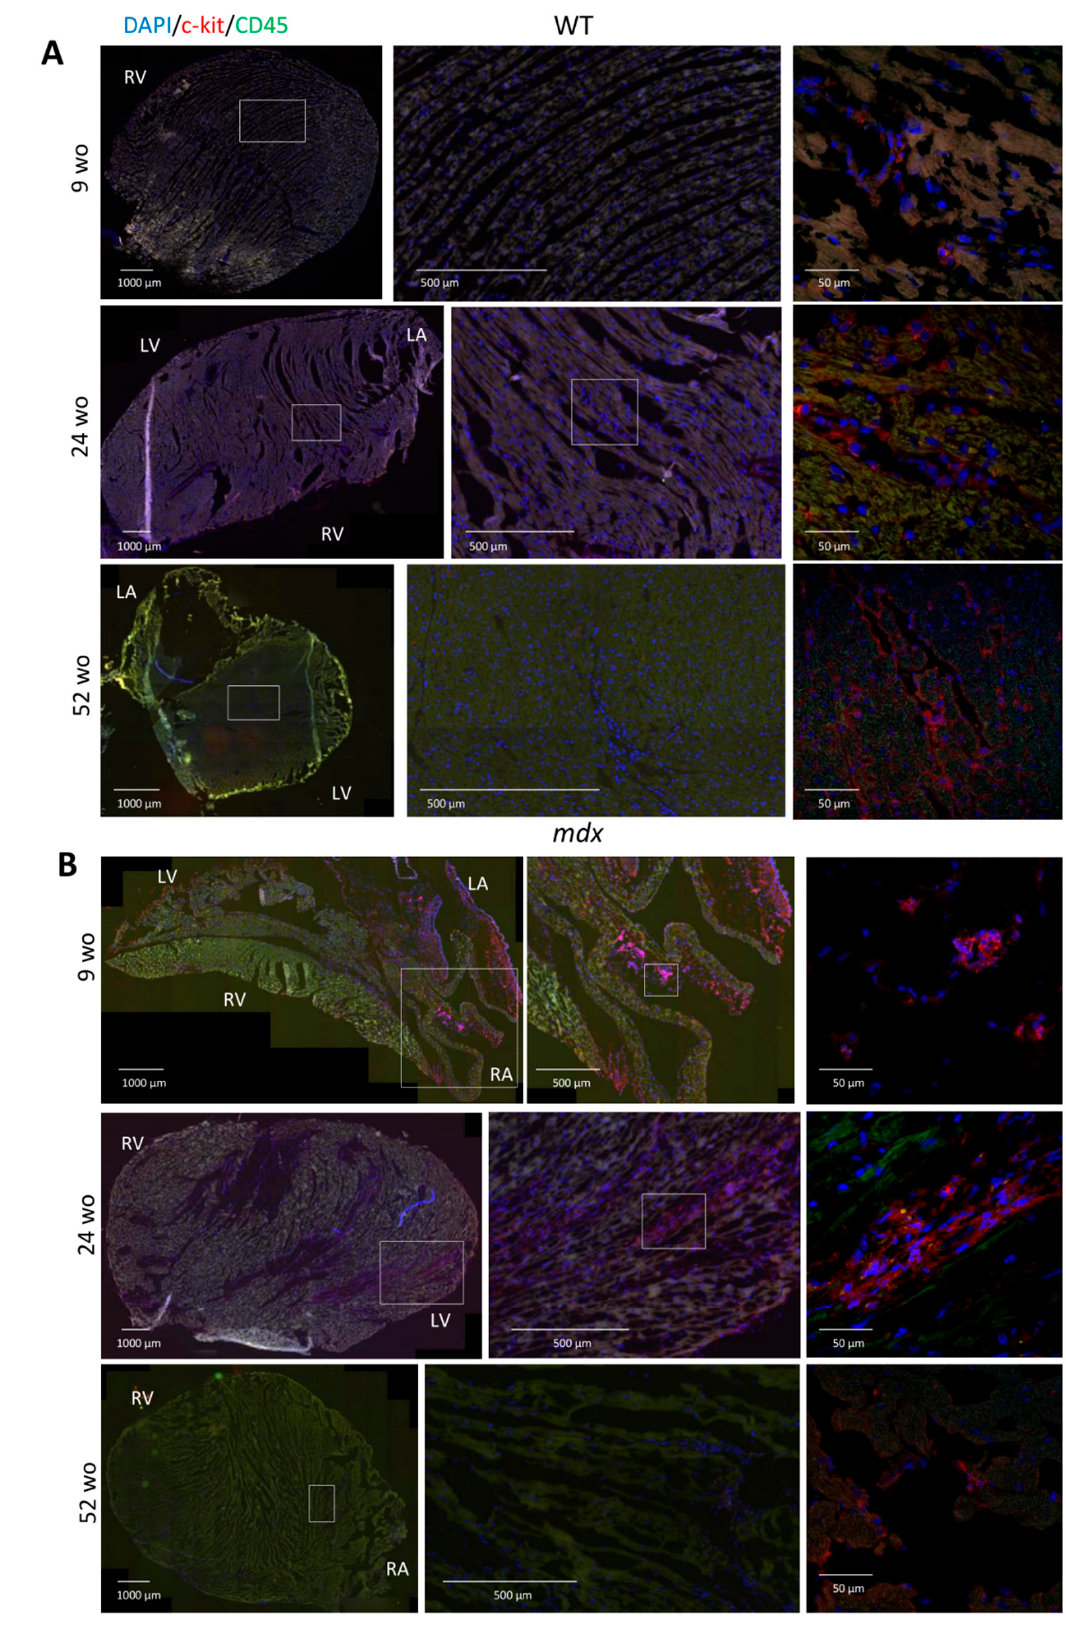
Figure 3. Abnormal age-dependent CVPC localization in the mdx heart. ( A ) Representative images of CVPC localization in WT hearts at the age of 9 (upper panels, n = 3 animals), 24 (middle panels, n = 2 animals), and 52 wo (lower panels, n = 4 animals). ( B ) Representative images of CVPC localization in mdx hearts at the age of 9 wo (upper panel, three animals),